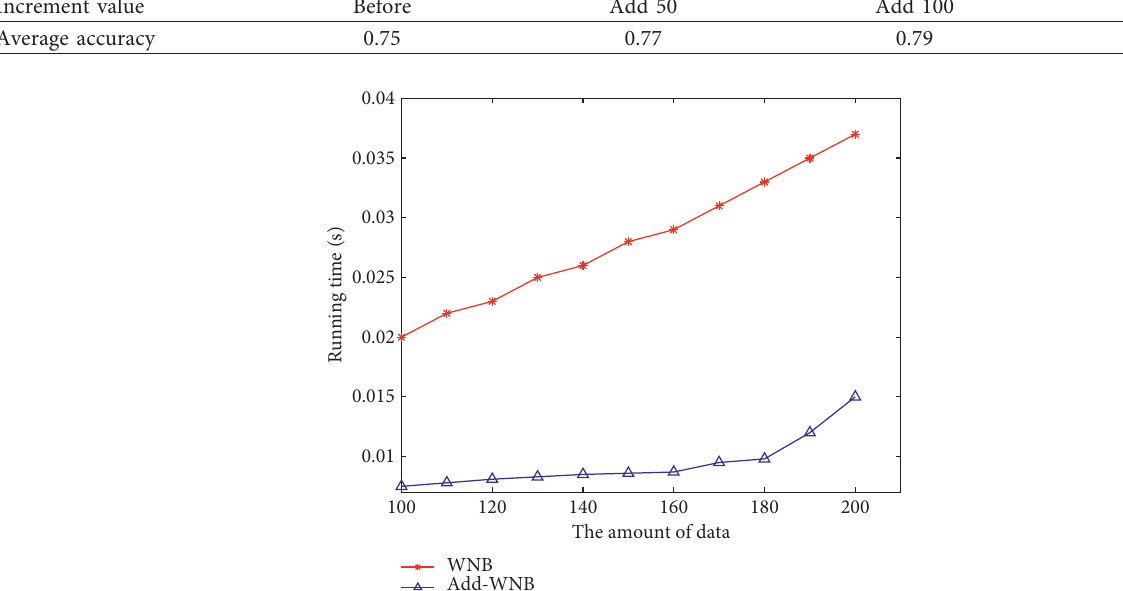
Figure 6: Algorithm runtime